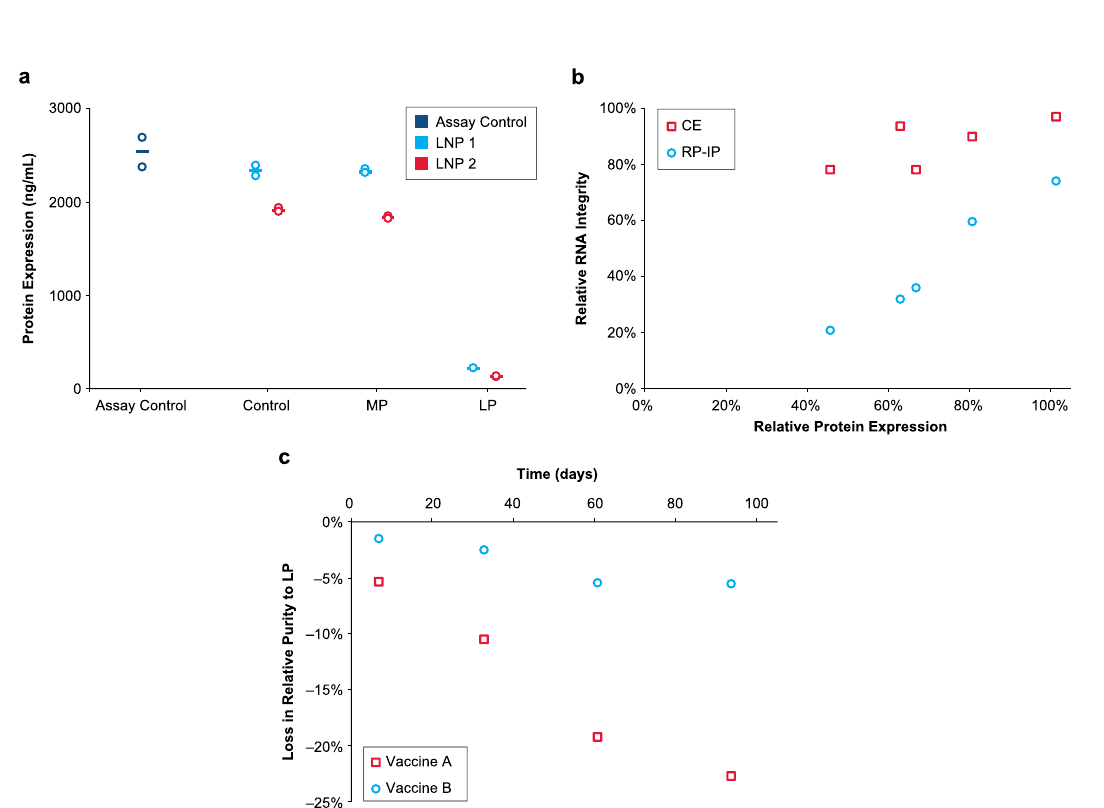
Fig. 5 N-oxide as a driver of adduct formation. a Tertiary-amine-containing ionizable lipids currently used in RNA-lipid nanoparticle (RNA-LNP) products. b N-oxide forms through tertiary amine oxidation and undergoes an acid/base-catalyzed hydrolysis at the amine to generate aldehydes and secondary amines. c N-oxide acid hydrolysis products were detected by reversed phase-ultra-high-performance liquid chromatography with charged aerosol detection and tandem mass spectrometry (RP-UPLC-CAD MS/MS); N-oxide standard (green), acid-precipitated N-oxide standard with (blue) and without (red) aminooxy-polyethylene glycol (aminooxy-PEG) label, and buffer baseline (black). Secondary amines from N-oxide hydrolysis elute at 8.7, 10.3, and 25 min. Corresponding aminooxy-PEG-derivatized aldehydes elute at 9.5 and 16 min, with the third likely in the column void. pA, pico ampere. d Binary reactions of mRNA with pure N-oxide result in high late eluting-peak (LP). RP-IP analysis of mRNA extracted from the binary is shown at 3 h (black), 1 day (blue), and 3 days (red) MP, mRNA main peak. e Binary reactions spiked with pure 17-carbon aldehyde and f pure 25-carbon aldehyde products from the N-oxide degradation pathway result in high levels of mRNA modi fi cation. Reversed phase-ion pair high performance liquid chromatography (RP-IP HPLC) chromatograms of the extracted mRNA are shown with no aldehyde spike (black), 0.5% aldehyde (red), and 2% aldehyde (green). g , h Binary reactions with the pure 17-carbon aldehyde from the N-oxide degradation pathway were analyzed for single nucleoside modi fi cations. Binaries were prepared with no aldehyde (black), 0.5% aldehyde (red), 1% aldehyde (blue), and 2% aldehyde (green) spike. mRNA was extracted, enzyme-digested, and analyzed by liquid chromatography with tandem mass spectrometry (LC-MS/MS). The mass-to-charge ratios (m/z) corresponding to aldehyde-cytidine adducts (m/z 526.3 and 540.3) increased with aldehyde spike level. A representative ionizable lipid system, heptadecan-9-yl 8-((2-hydroxyethyl)(6-oxo-6-(undecyloxy) hexyl)amino)octanoate is used here. Representative data from ≥ 3 repeat experiments are shown.